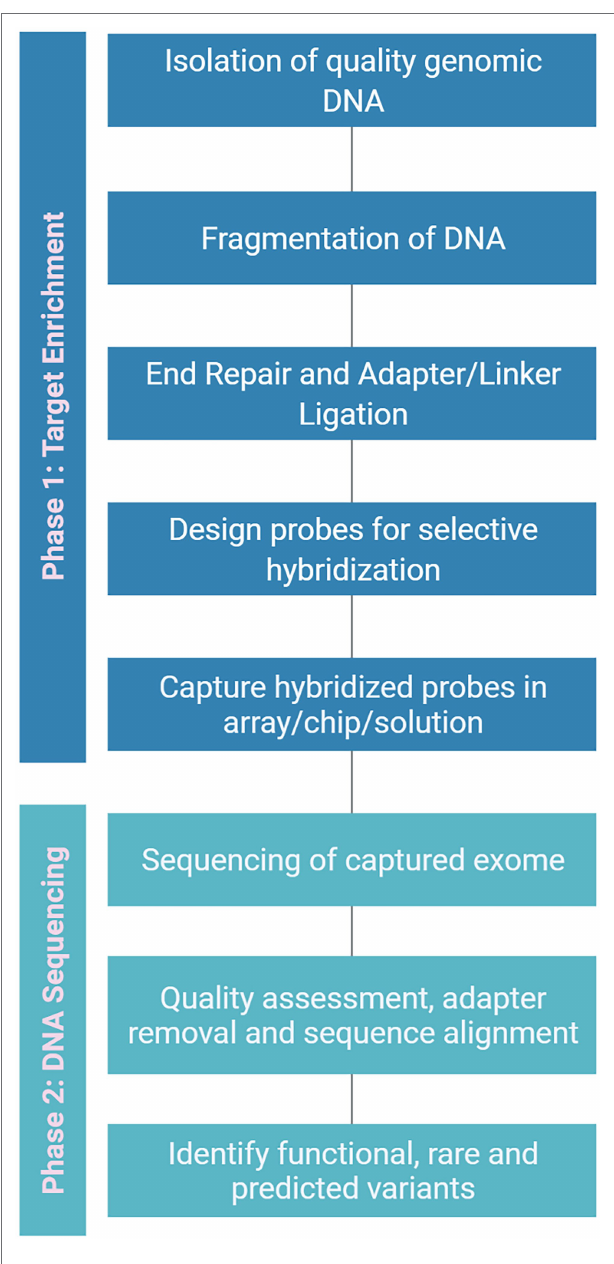
FIGURE 5 | A generalized flowchart for exome capture to isolate the exon variants. It can be broadly divided into two phases viz ., target enrichment and DNA sequencing. In enrichment phase high-quality genomic DNA is isolated and specific probes are designed for hybridization followed by capturing of hybridized probes. In sequencing phase, the raw exome sequence data is filtered and aligned to find potential